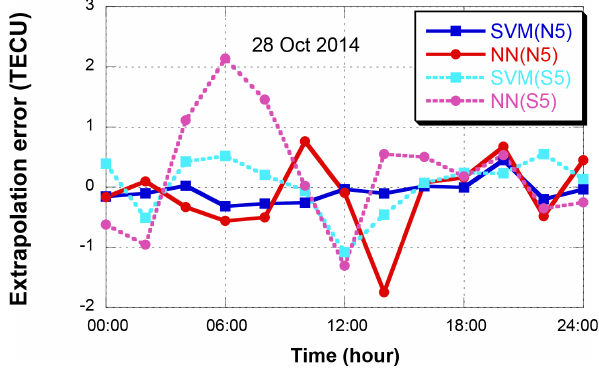
Figure 10. Extrapolation errors for each direction (10 ◦ extrapola- tion